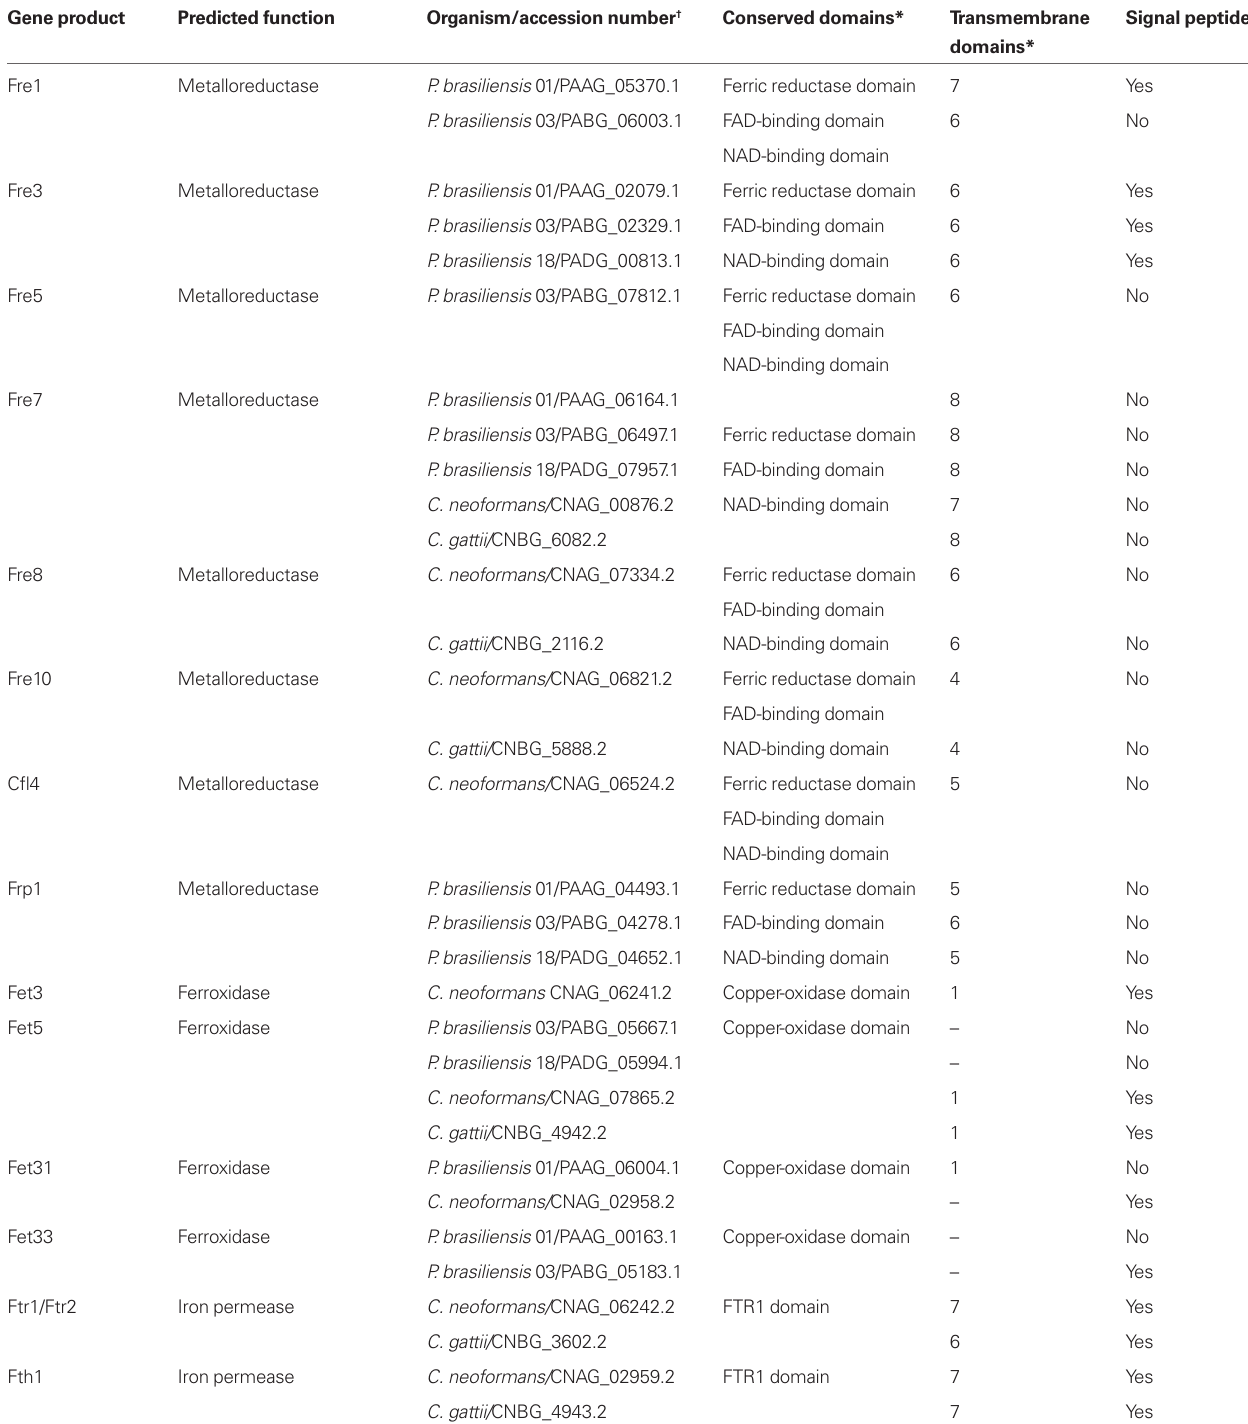
Table A1 | Conserved domains in proteins involved in iron, copper and zinc uptake by reductive systems in P. brasiliensis isolates and Cryptococcus